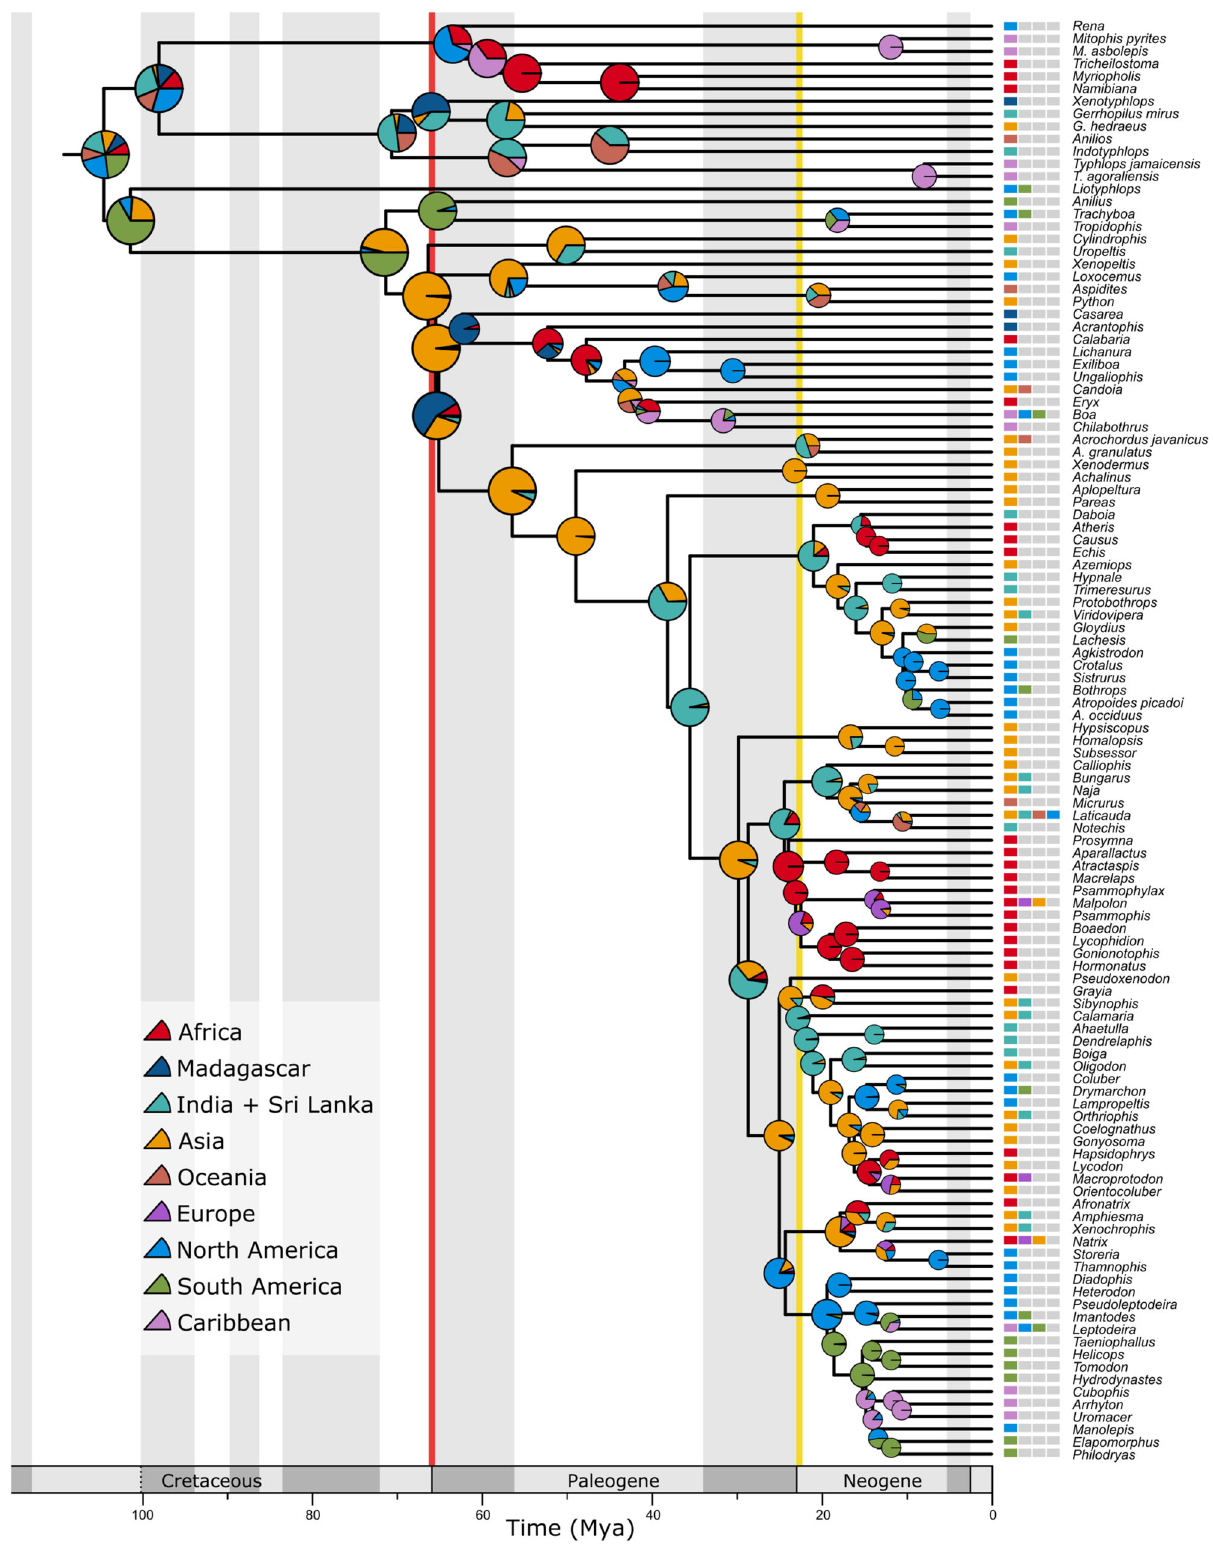
Fig. 3 Reconstructed historical biogeography of crown snakes, applying the DIVAlike + J model from BioGeoBEARS. Pies represent the likelihood of the presence in each geographic area for each node; squares indicate present-day geographic distributions of extant taxa. The K-Pg boundary is indicated by a red line and the Oligocene-Miocene boundary by a yellow